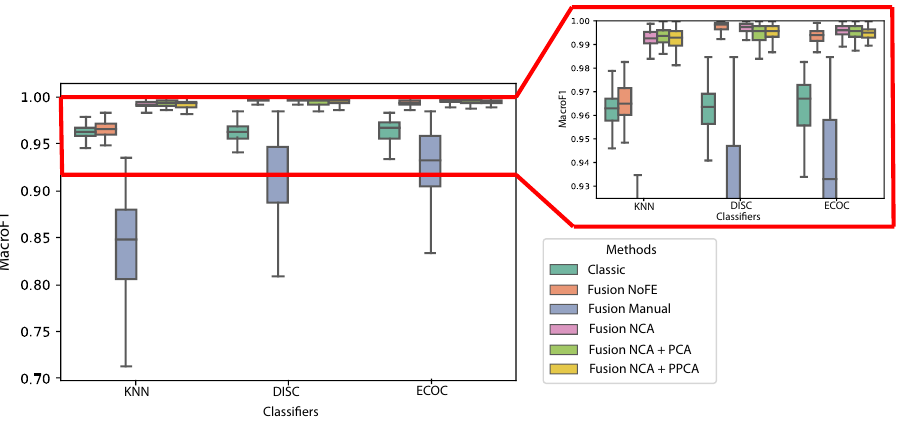
Figure 7. Macro-averaged F1 score of the classifiers for the different configurations of classic and contextualized scenarios and feature engineering (FE)